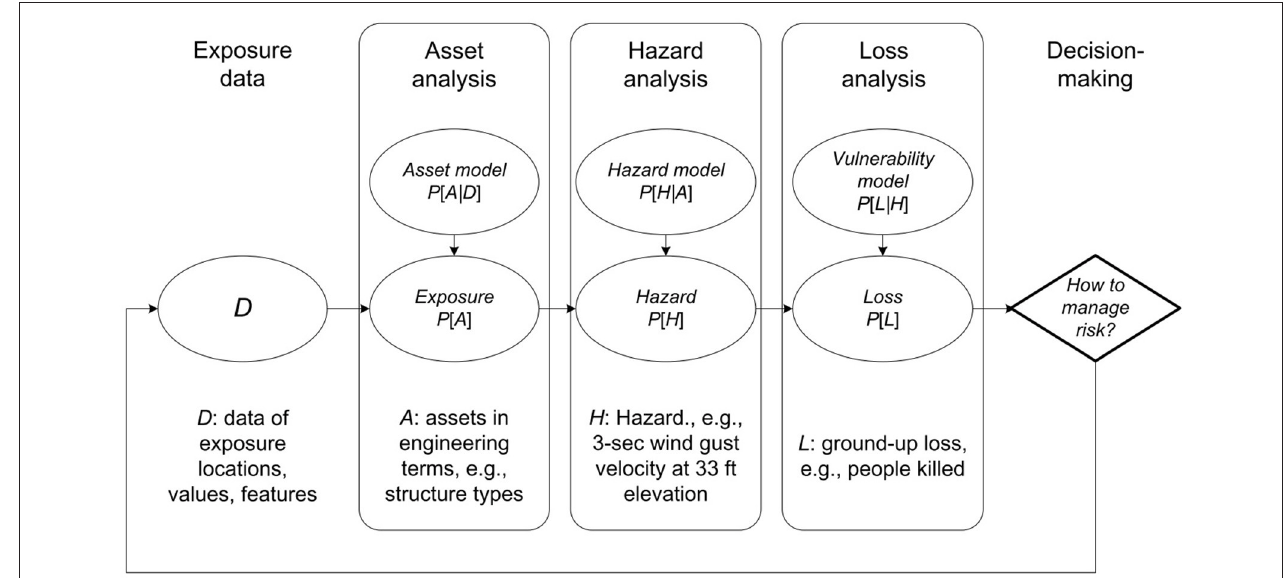
FIGURE 2 | An engineering approach to risk analysis (Porter,